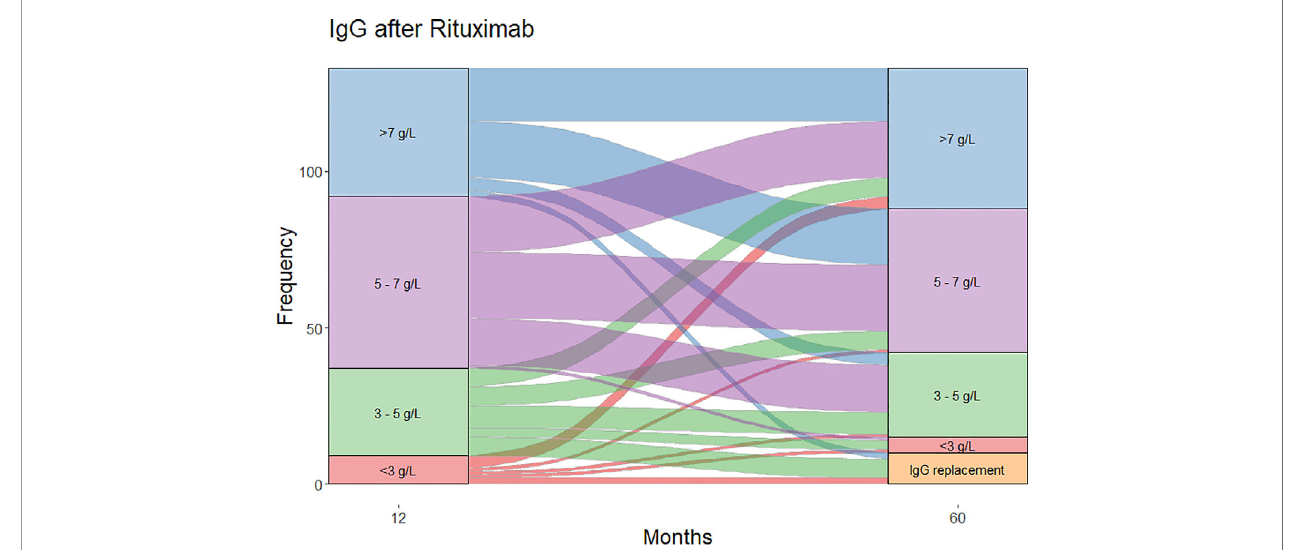
FIGURE 2 | Change in IgG strata between month 12 and month 60 of follow-up.